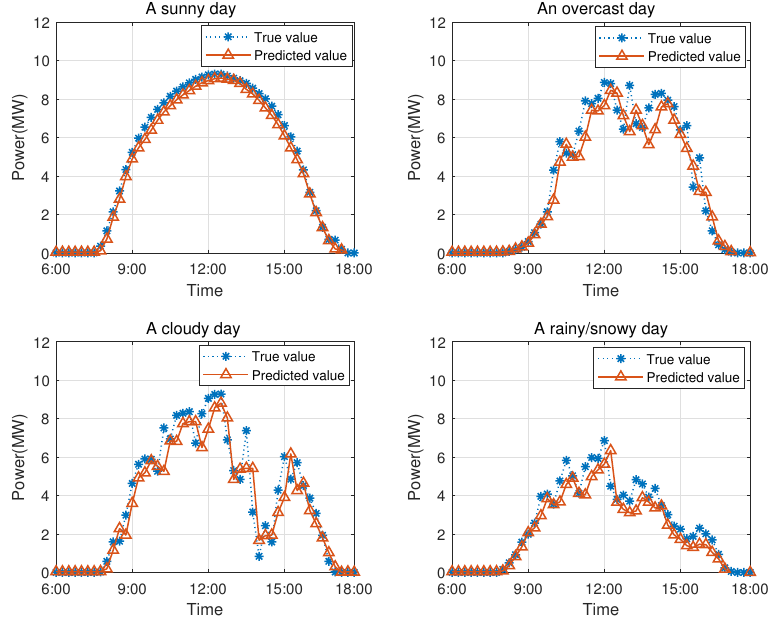
Figure 11. The comparison of forecast results under four generalized weather types.